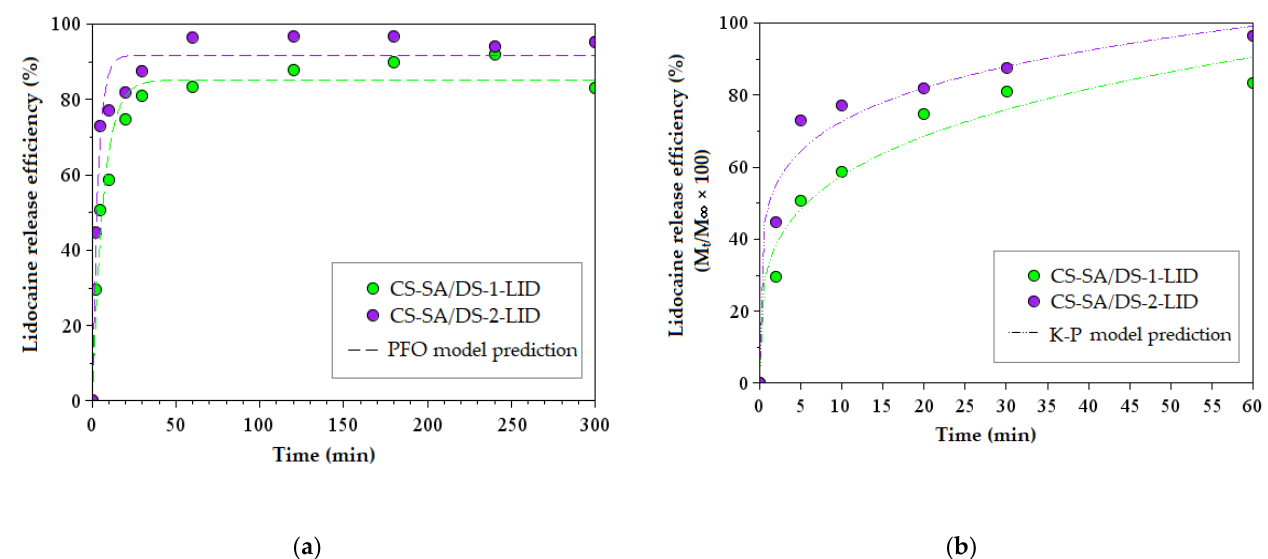
Figure 7. In vitro lidocaine release from chitosan porous membranes and experimental data processing by: ( a ) fitting by pseudo-first order (PFO) kinetic model; ( b ) fitting by Korsmeyer – Peppas (K – P) kinetic model (with the processing of the first 60% of data).